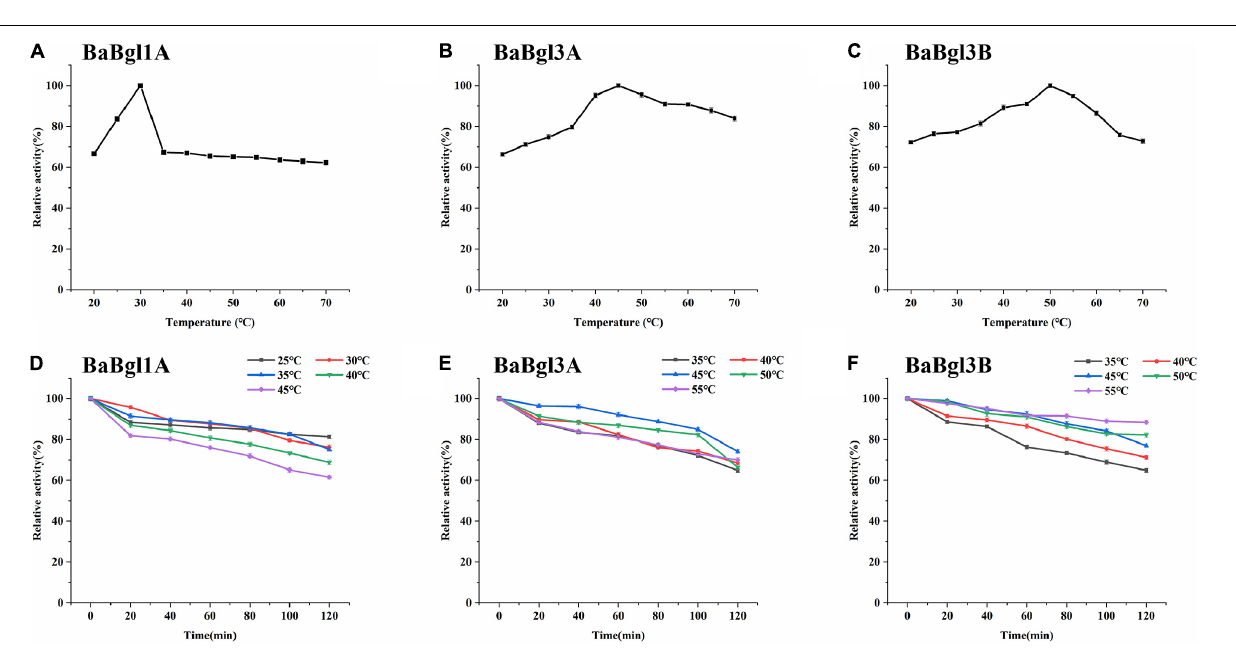
FIGURE 3 | Temperature profiles of the purified recombinant enzymes (BaBgl1A, BaBgl3A, and BaBgl3B). The effects of temperature and stability on BaBgl1A are shown in (A,D) . The effects of temperature and stability on BaBgl3A are shown in (B,E) . The effects of temperature and stability on BaBgl3B are shown in (C,F) . BaBgl1A was tested in the buffer of 50 mM NaAc (pH 6.0). BaBgl3A and BaBgl3B were tested in the buffer of 50 mM Na 2 HPO 4 –NaH 2 PO 4 (pH 6.5). Values are mean ± SD from three biological